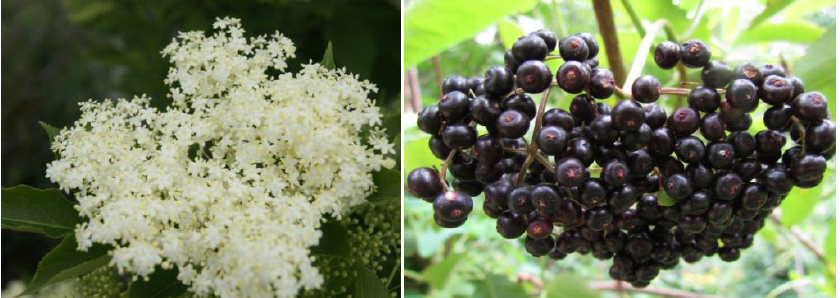
Figure 2. Flowers and fruits of Sambucus nigra (Atkinson and Atkinson, 2002) It has a cool and dry nature and can be used to relieve constipation in the elderly and those with poor intestinal activity. This forest plant is effective in treating rheumatism, relieving joint pain, accelerating the development of broken bones and treating respiratory diseases. Oral and external use of this plant heals all kinds of skin lesions, heals skin irritation and brings freshness to the skin (Ebrahimzadeh et al. 2009a; Parker et al., 2003). The skin and leaves of this shrub contain materials such as sambosin, sambo nigerin, choline, cicotine and potassium nitrate. There is alderin 4 and a little essence in its flowers. Sambucus nigra also has Krizan Taemin 5, Sugar, essence, Gum, Valzianic acid and acetic acid (Ebrahimzadeh et al., 2009b). In this research, alongside with a comprehensive study of the effective substances in the two medicinal plants of nettle and elderberry, the effects of planting methods and the extraction methods of the active constituents from these plants have been analyzed. Figure 3 presented some process was used for the extraction of active constituents from herbal